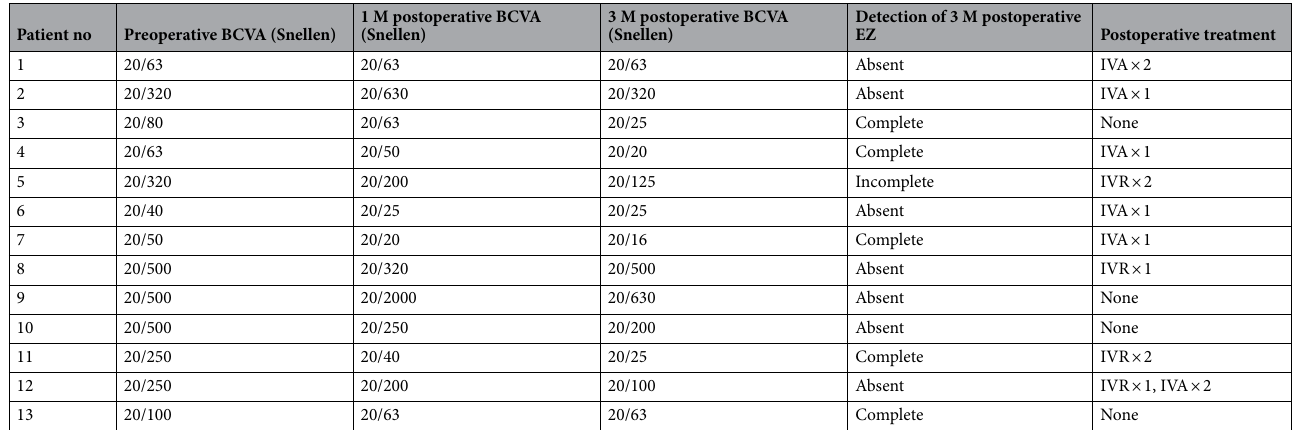
Table 3. Changes in BCVA and postoperative EZ